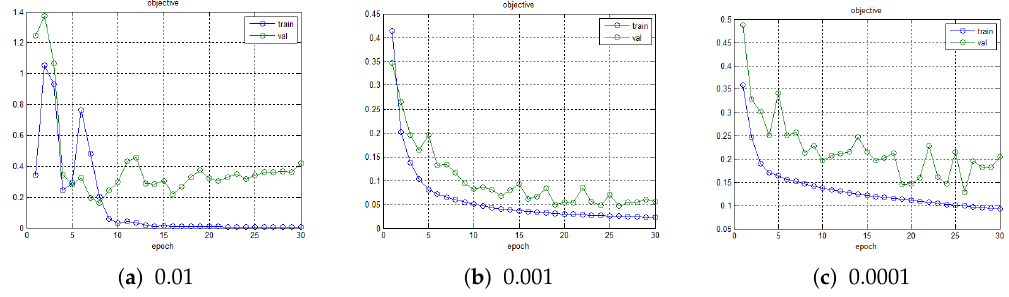
Figure 6. The loss curves with different learning